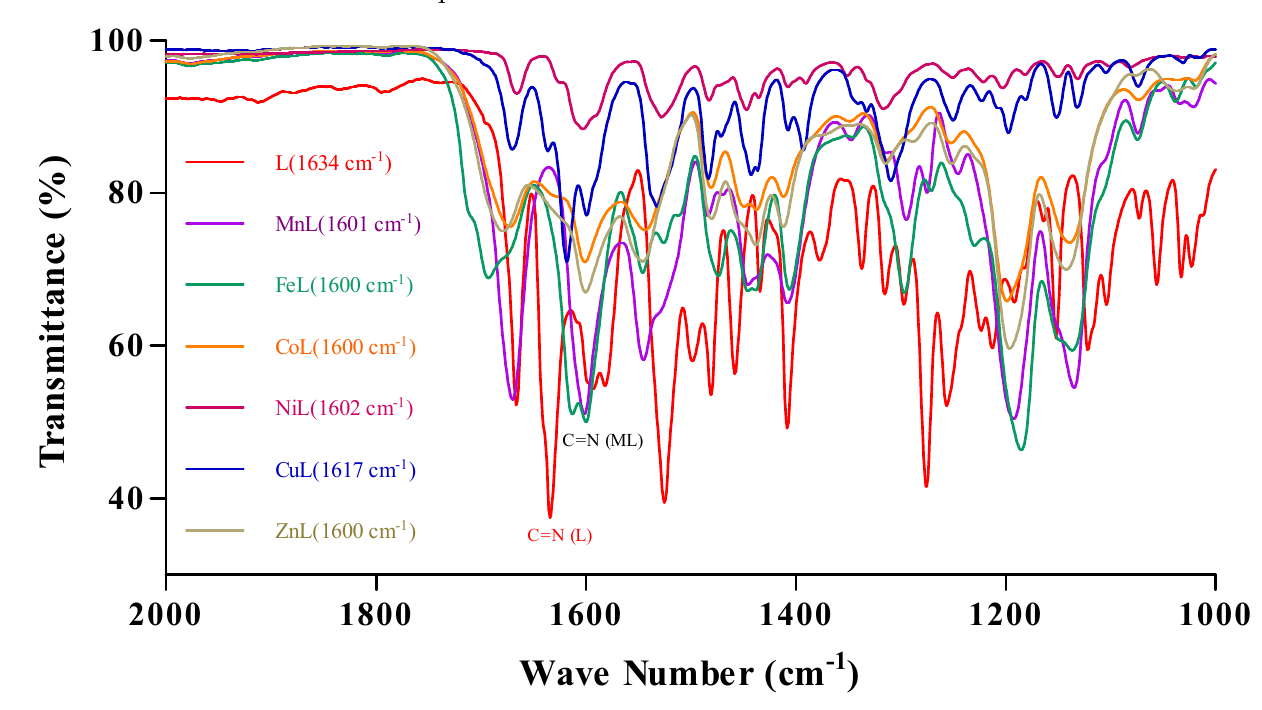
Figure 1. The FTIR spectrum of the Schiff’s base ligand ( L ) and transition metal complexes. The FTIR spectra indicated the presence of a C=N stretching vibration at 1634 cm −1 for the ligand ( L ) and a C=N stretching vibration downshift to 1600–1617 cm −1 , showing the coordination of Schiff bases and metal ions.